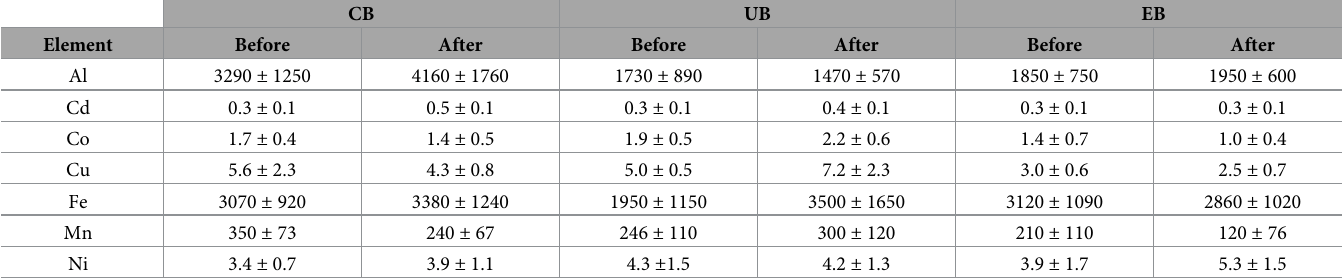
Table 2. Table of mean coastal seagrass metal concentrations before and after the wet season. Mean concentration and standard deviation (mg/kg (dw) ± SD) of metal elements in seagrass samples collected at each coastal site (CB, UB and EB) before and after the 2018/19 wet season. CB UB EB Element Before After Before After Before